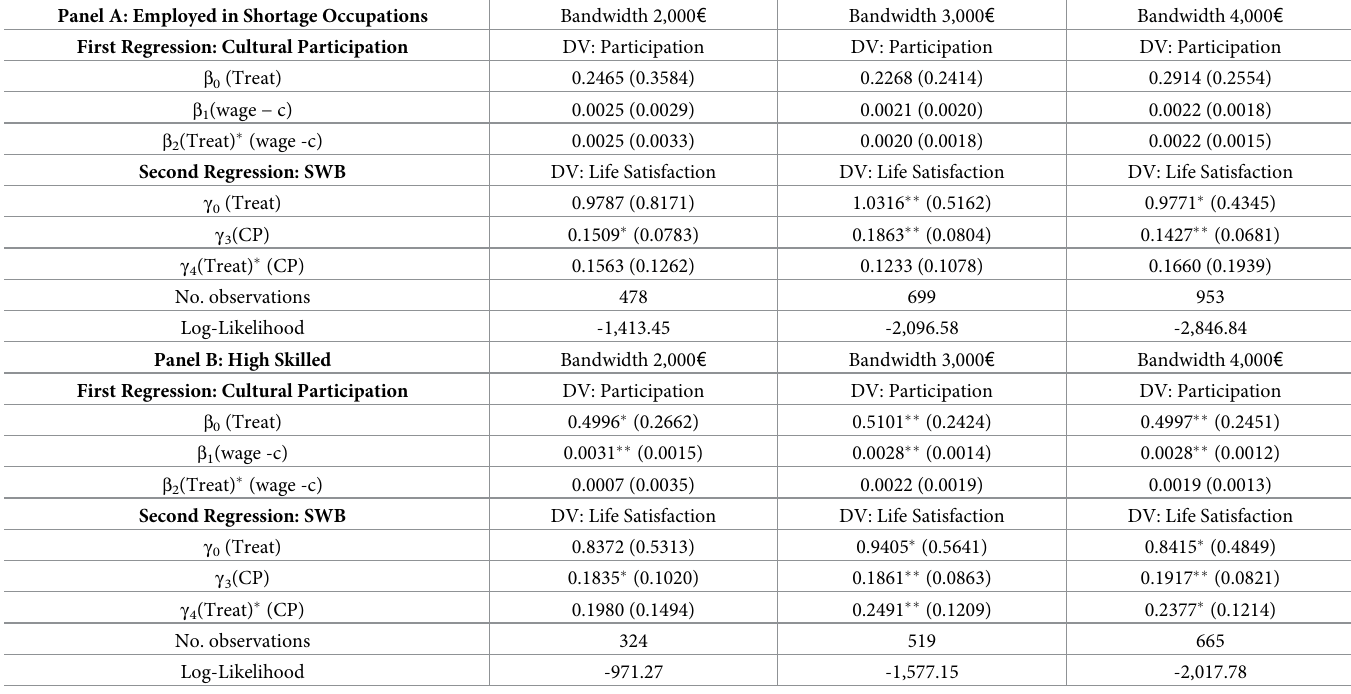
Table 6. RDD seemingly unrelated regression estimates using Ordered Probit and uniform Kernel for participation in practising artistic activities. Panel A: Employed in Shortage Occupations